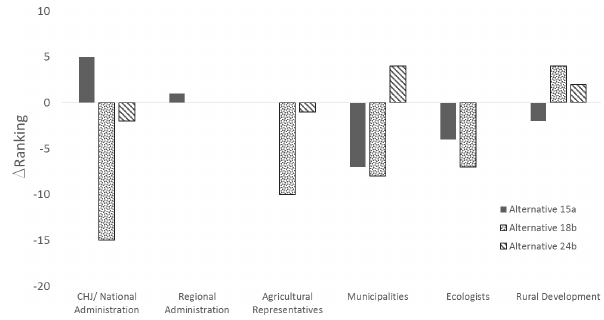
Figure 8. Change in ranking between scenario 1 and scenario 2 of the three best evaluated alternatives in scenario